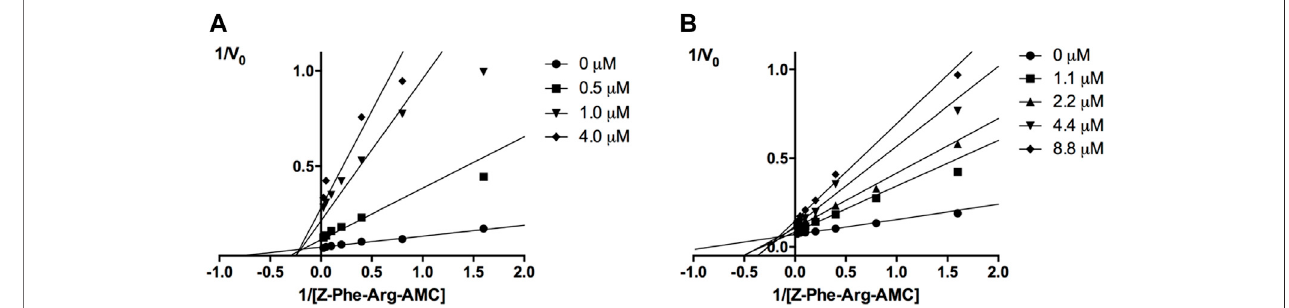
FIGURE 2 | Lineweaver-Burk plots for compounds 20 (A) and 24 (B) . Each curve represents a different inhibitor concentration.